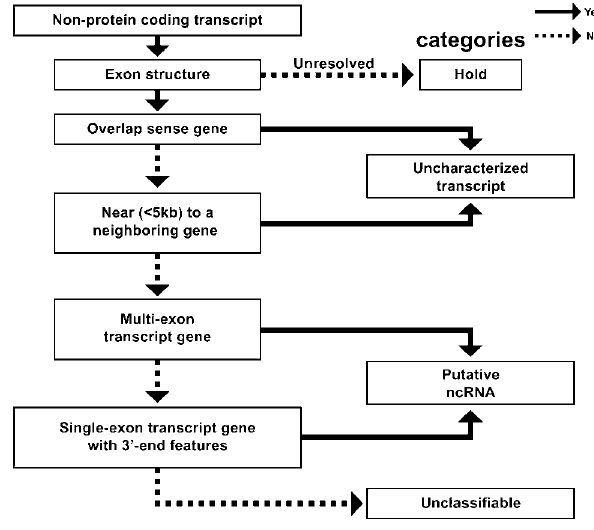
Figure 5. The Manual Annotation Flow Chart of ncRNAs Candidate non-protein-coding genes were compared with the human genome, ESTs, cDNA 3 9 -end features and the locus genomic environment. The candidates were then classified into four catego- ries: hold (cDNAs improperly mapped onto the human genome); uncharacterized transcripts (transcripts overlapping a sense gene or located within 5 kb of a neighboring gene with EST support); putative ncRNAs (multiexon or single exon transcripts supported by ESTs or 3 9 -end features); and unclassifiable (possible genomic fragments).